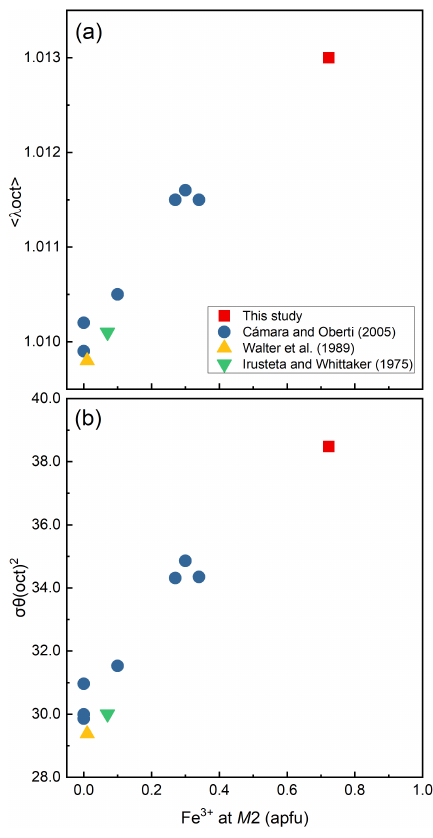
Figure 5. Variations of the bond-length distortion, <λ oct > , (a) and the angle variance, σ 2 (oct), (b) of the M 2O 6 octahedra against θ Fe 3 + content (apfu) at the M 2 site.